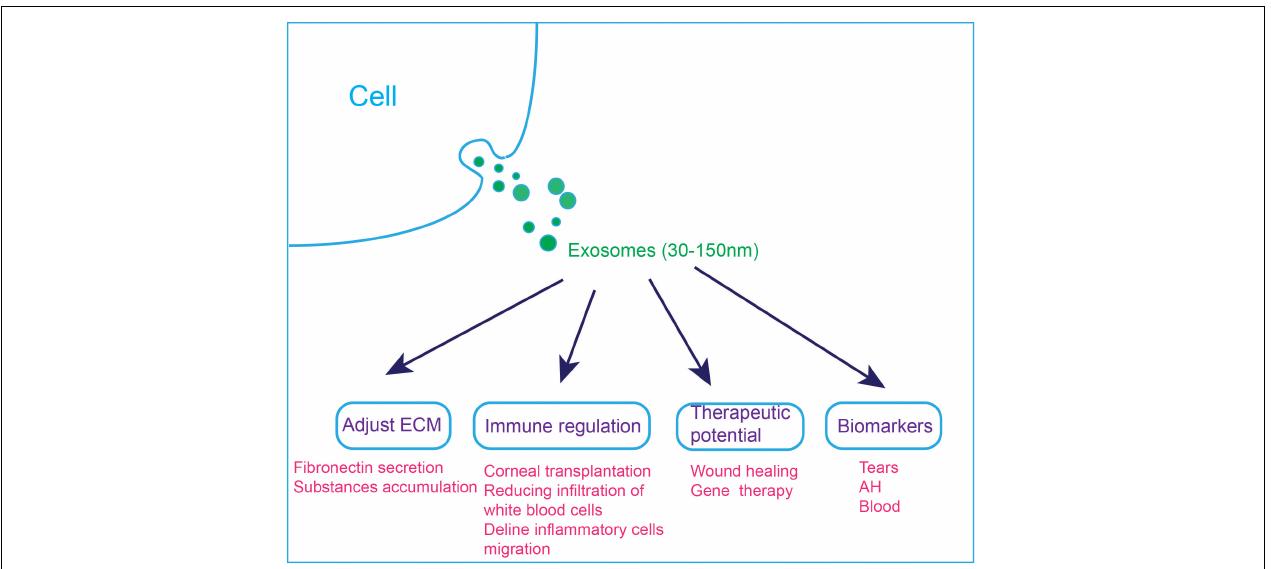
FIGURE 4 | Applications of exosomes in the visual and auditory systems. (1) Exosomes are involved in cell ECM changes. Dexamethasone treatment decreases the affinity of exosomes to fibronectin, which can explain the abnormal accumulation of ECM substances in steroid-induced glaucoma patients. (2) Exosomes are involved in immune regulation, and they can reduce immune rejection after corneal transplantation. MSC-derived exosomes ameliorate autoimmune uveoretinitis by inhibit the migration of inflammatory cells and decline the infiltration of white blood cells into the eye. (3) Exosomes can accelerate wound healing and exo-AAVs are considered to be a novel gene therapy tool. (4) Exosomes in tears, AH and blood have the potential to be used as diagnostic markers.